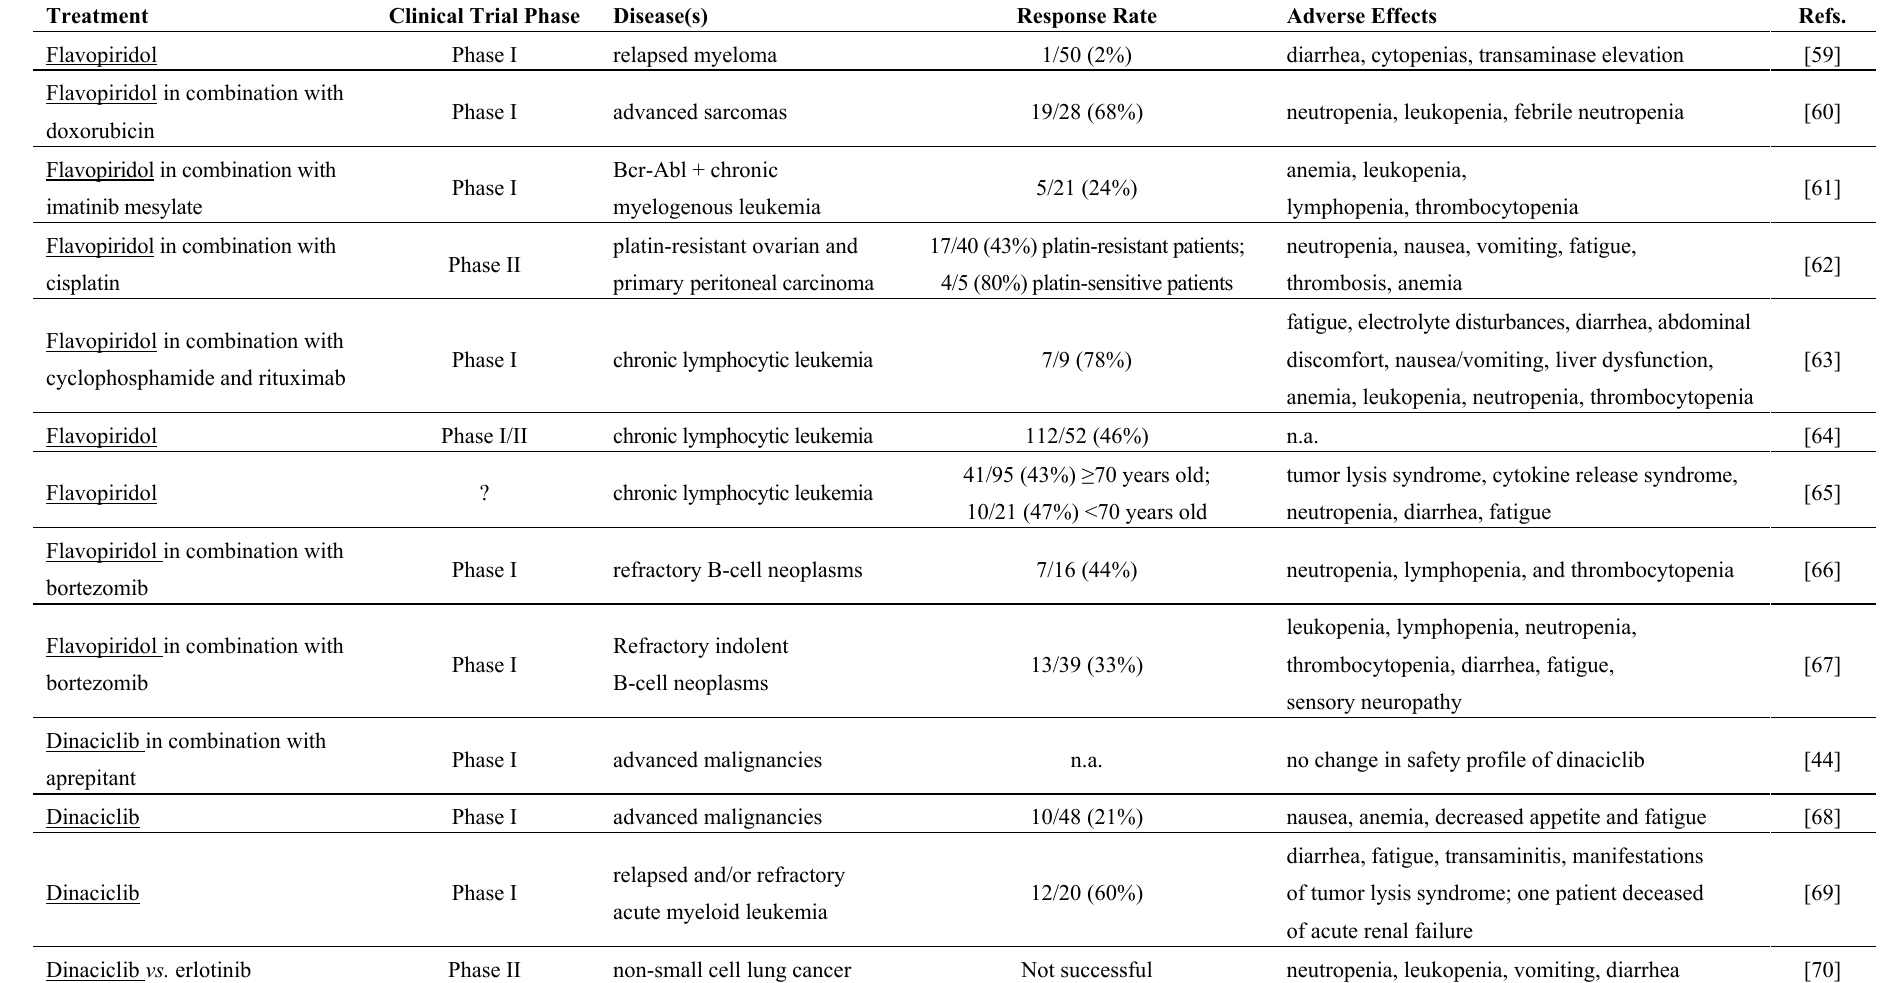
Table 3. List of CDK inhibitors described in clinical study